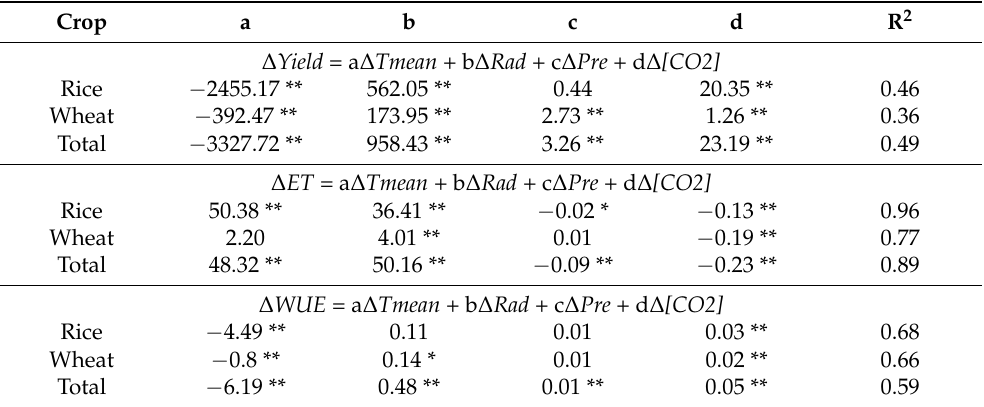
Table 2. Coefficients in the regression analysis for the impacts of climate change on yield, ET, and WUE change. Crop a